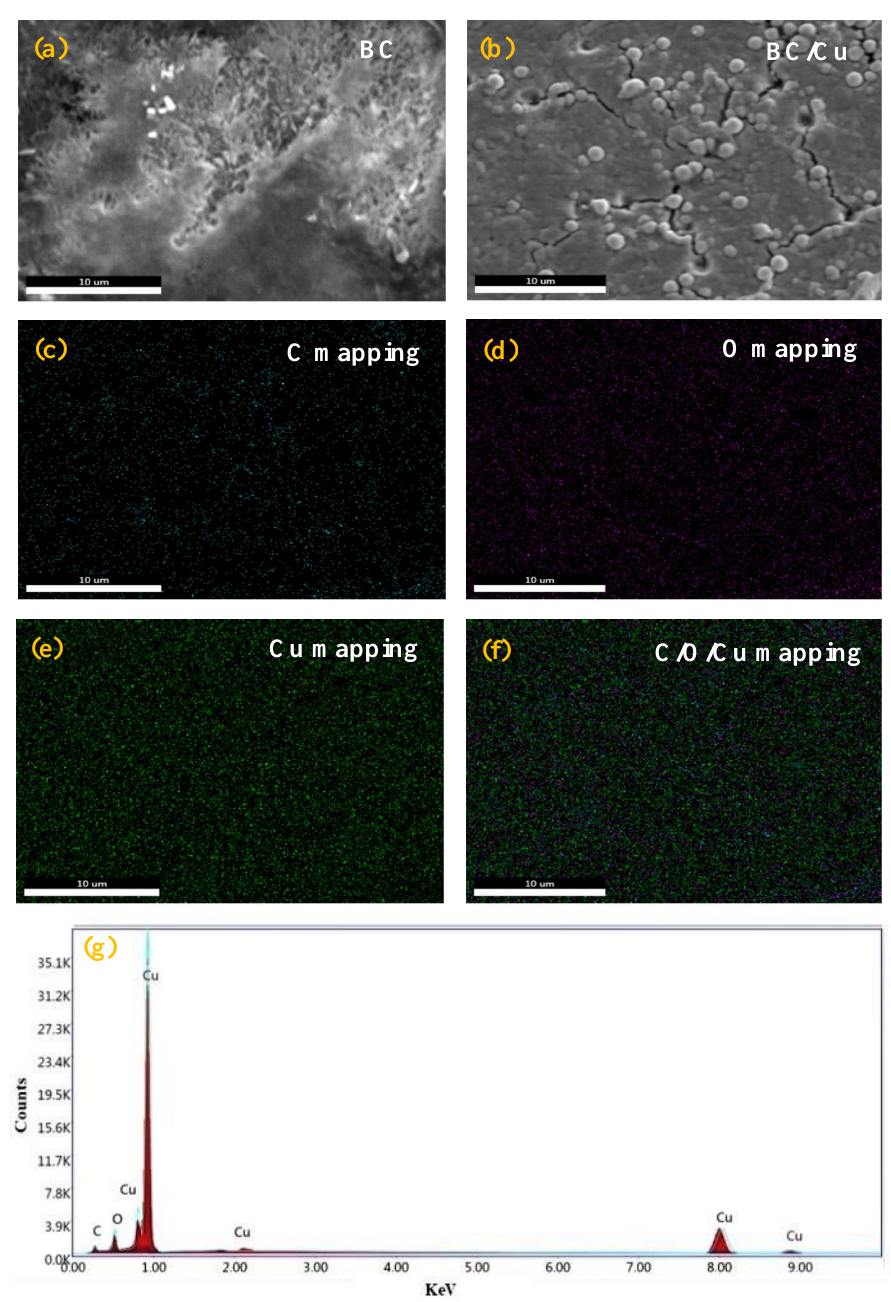
Figure 5. Elemental distribution in bacterial cellulose/copper nanocomposite; EDS-SEM ( a – f ) representation of element mapping; ( g ) distinguished peaks of elements.